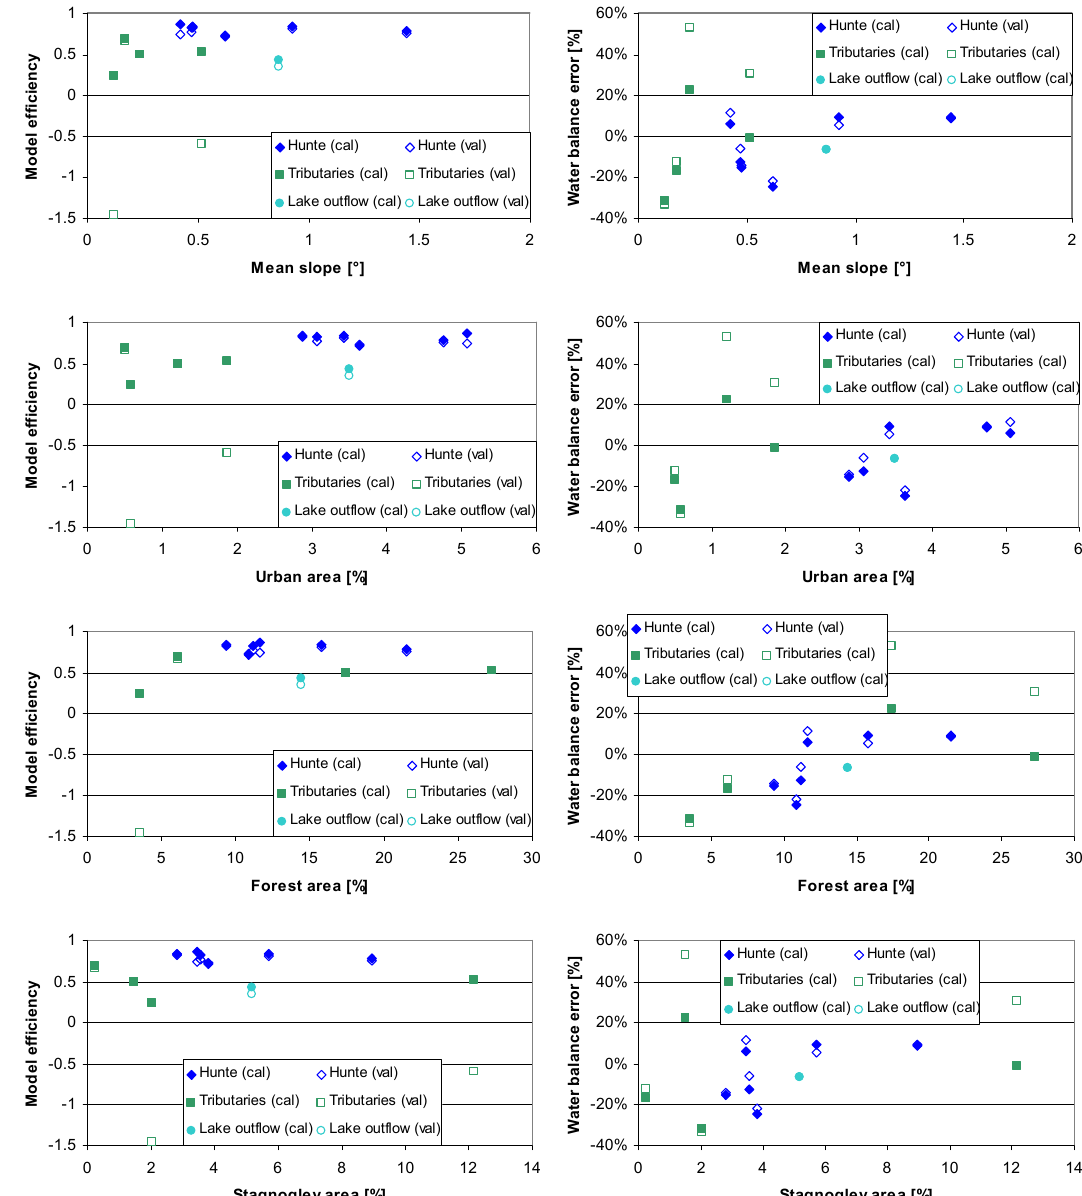
Fig. 5. Correlation of quality measures (model efficiency, mean absolute annual water balance error) to selected physiographic catchment characteristics: mean slope [ ◦ ], urban area [%], forest area [%], stagnogley soils